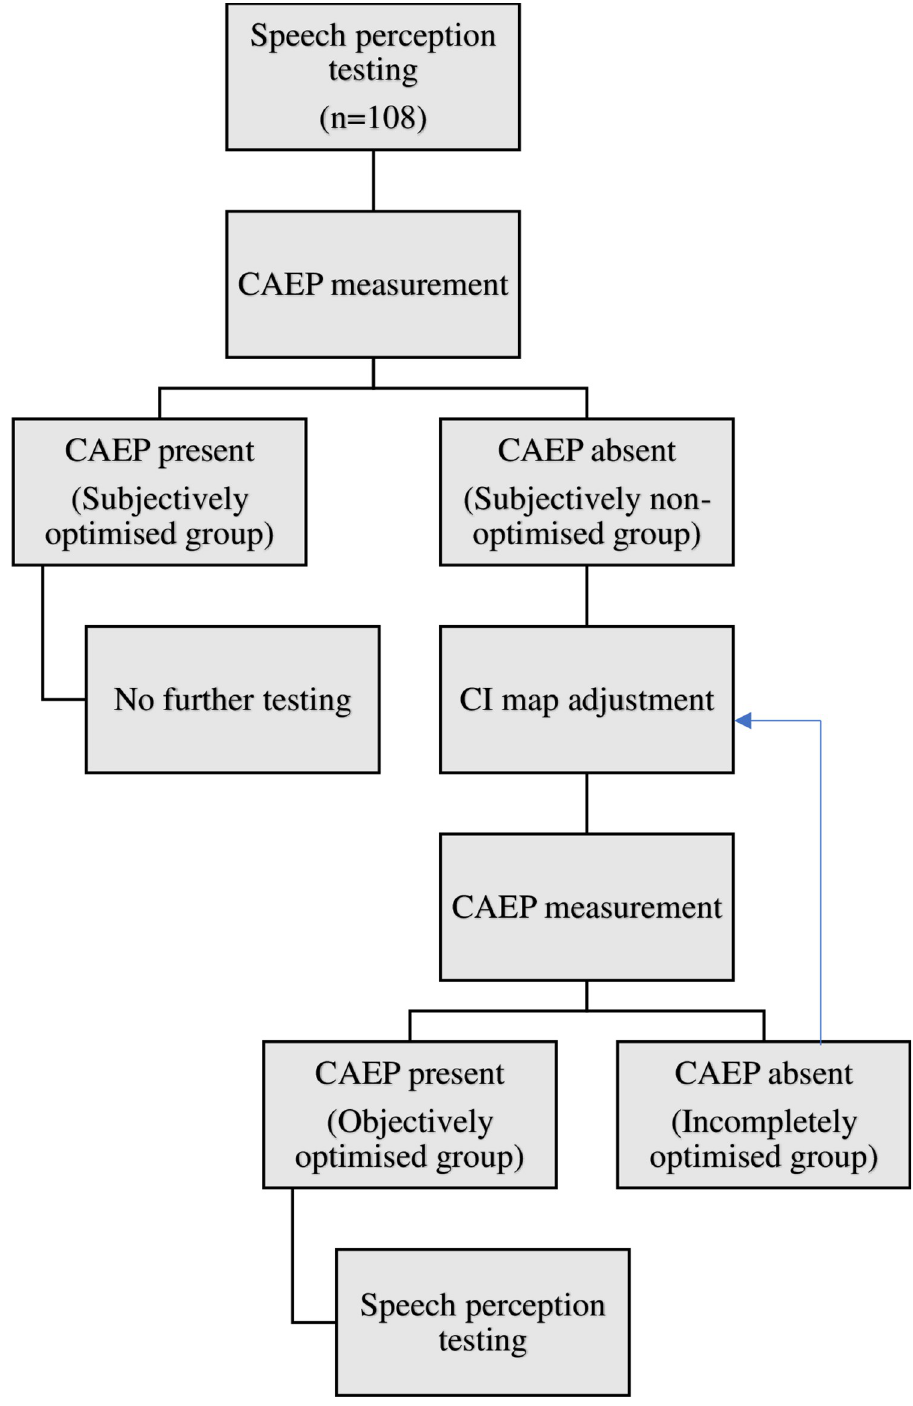
Fig 2. Visual representation of the testing protocol and the participants breakdown forming the four groups.